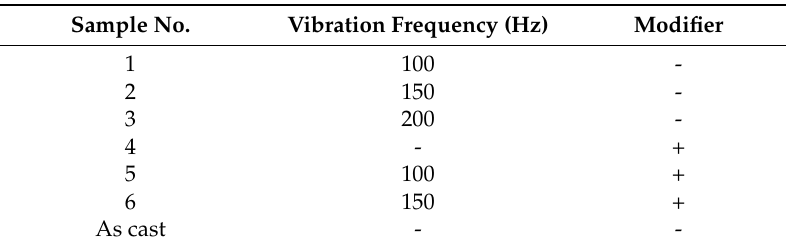
Table 3. Experimental procedures list.